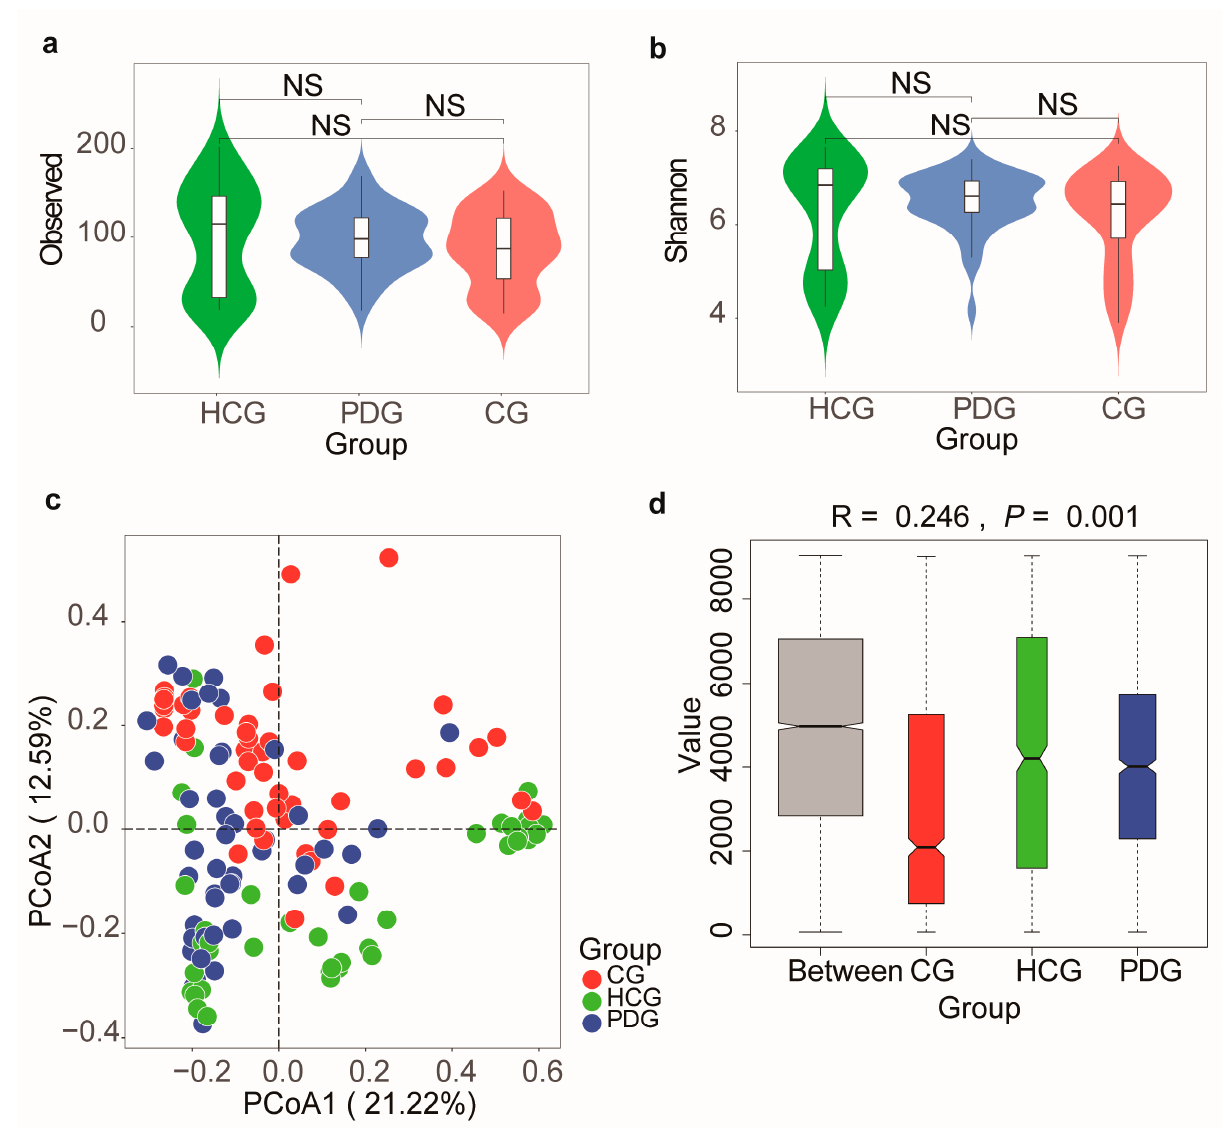
Figure 4. Oropharynx microbial alterations in diversities among HCG, PDG, and CG. Alpha diversity among HCG, PDG, and CG, as illustrated by the ( a ) Observed index (NS: p > 0.05) and ( b ) Shannon index (NS: p > 0.05). ( c ) Principal coordinate analysis (PCoA) based on Bray–Curtis (weighed) distance showed obvious changes in beta diversity among HCG, PDG, and CG. The colors represent three different groups. PCoA1 and PCoA2 represent the top two principal coordinates that captured most of the diversity. The fraction of diversity captured by the coordinate is valued as a percentage. ( d ) The analysis of similarities (ANOSIM) based on Bray–Curtis (weighed) distance (R > 0, and p < 0.05). The R means the statistical value of ANOSIM, and y-axis value means Bray–Curtis rank. NS: not significant. HCG: healthy control group. PDG: period of disease group. CG: convalescent group.